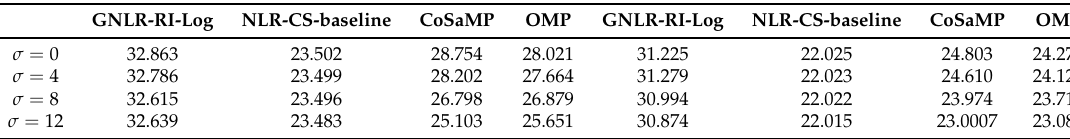
Table 6. The performance indexes PSNR (dB) with different reconstruction methods and noise levels. Landsat 8 Band 4 (reference: Band 8) and MODIS Band 6 (reference: Band 7).